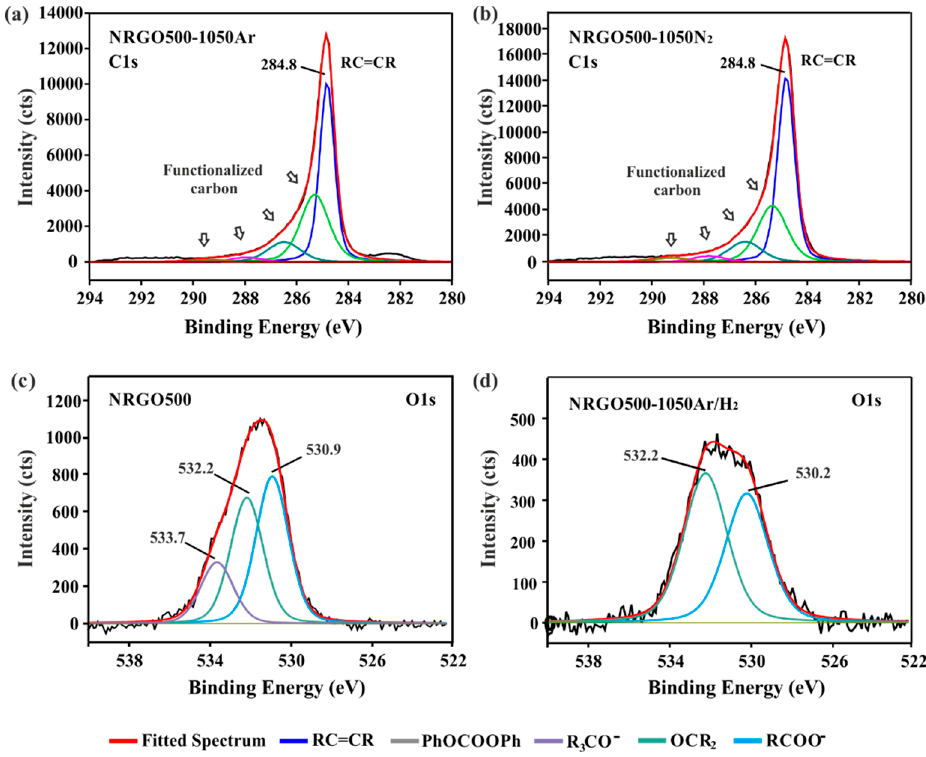
Figure 1. High-resolution C1s spectra of ( a ) NRGO500-1050Ar, ( b ) NRGO500-1050N 2 and O1s spectra of ( c ) NRGO500, and ( d ) NRGO500-1050Ar/H 2 .